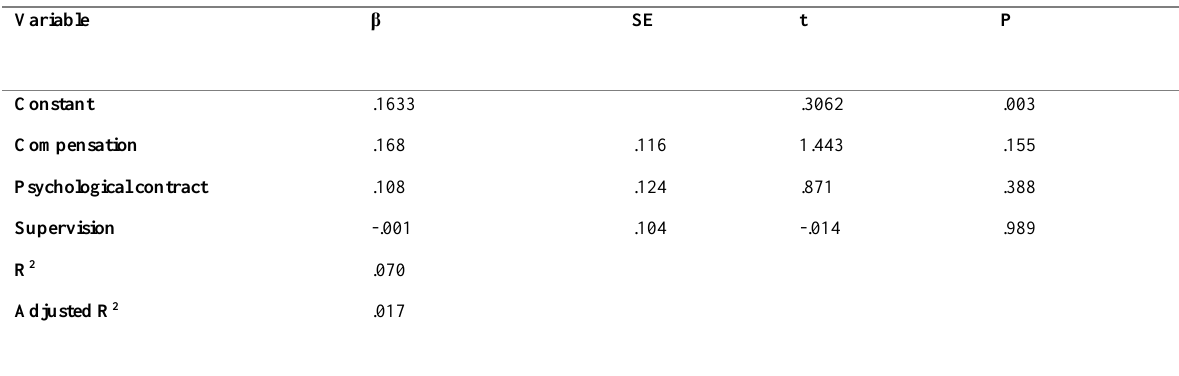
Table 4: Regression